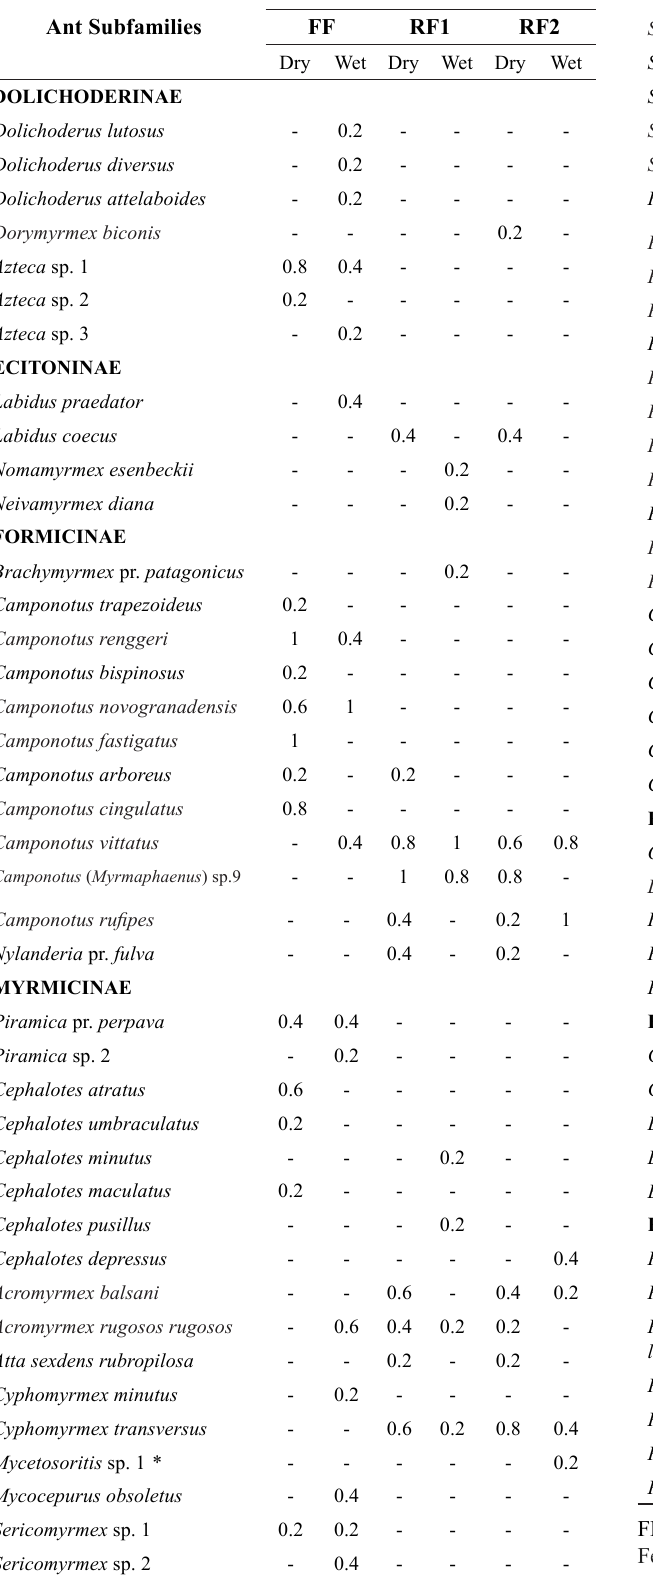
Table 1 . Relative frequency of epigeic ant species collected in pit- falls, during the wet and dry season of 2012 in three sites of different forest regeneration stages: a fragment of secondary forest (FF) one area of reforestation with five years (RF2) and other with seven years of reforestation